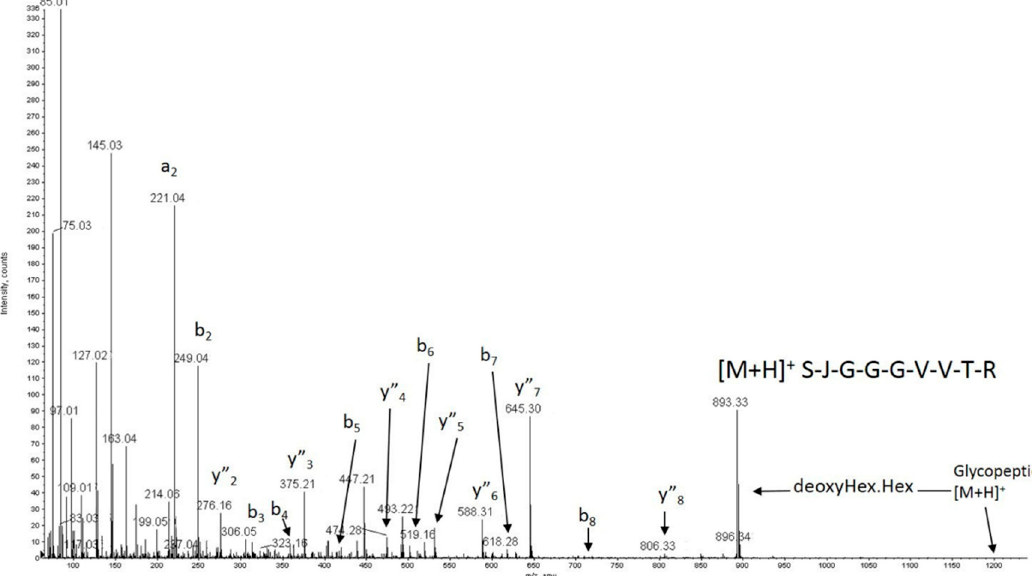
Figure 3. The MS / MS spectrum of m / z 601.22 + showing (i) the b and y” ions used to assign the sequence within ADAMTS13 WT (as SJGGGVVTR), and (ii) the facile loss of 308.1 Da from the quasimolecular ion to give m / z 893.3 corresponding to the loss of a DeoxyHex.Hex disaccharide. Data from the MS (low energy) spectrum show an initial loss of Hexose followed by Deoxyhexose, confirming the substitution order expected for GlucosylFucose at the JXXSJG consensus site (here JSRSJG) seen in other TSRs [41]. J = Carboxymethyl Cysteine.